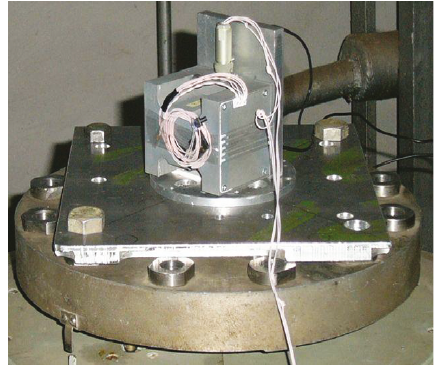
Figure 2: CVG mounted on shocker ’ s platform.